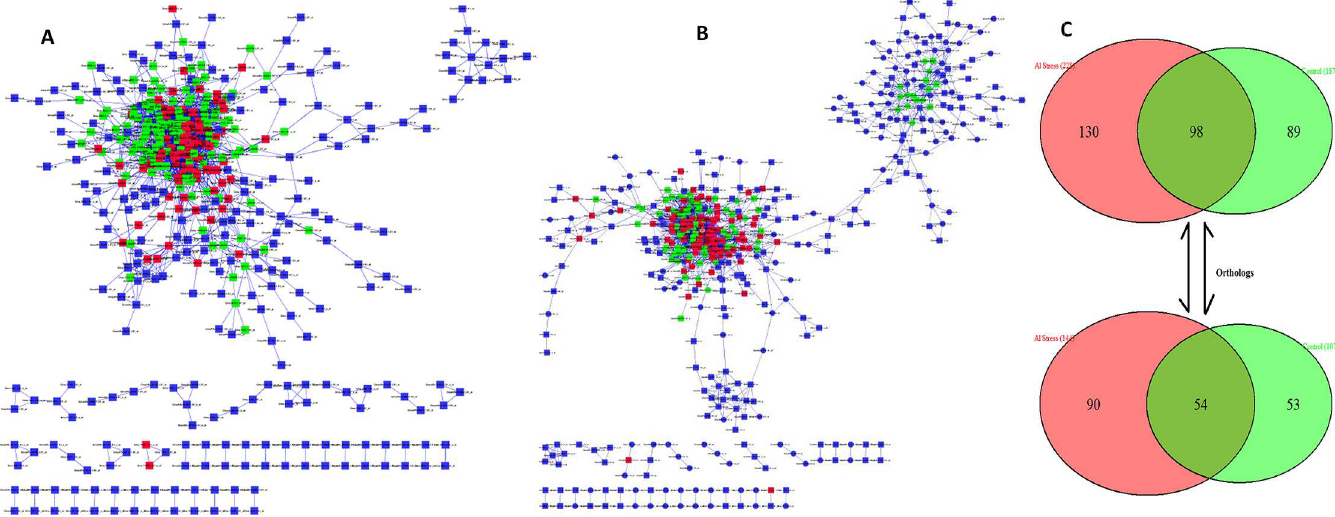
Fig 7. Gene Co-expression Networks for two differential conditions in soybean. The GCNs are constructed for Al stress (A) and control (B) conditions respectively. The nodeswith red colors represent the housekeeping hub genes, green color nodesrepresent UHG and blue color nodesrepresent the non- hub genes. (C) Venn diagramof hub genes in the GCNs constructed under Al stress (A) and control (B) conditionsin soybean.The number of orthologous genesfound in Arabidopsis correspondingto uniqueand common hub genesin soybeanis also